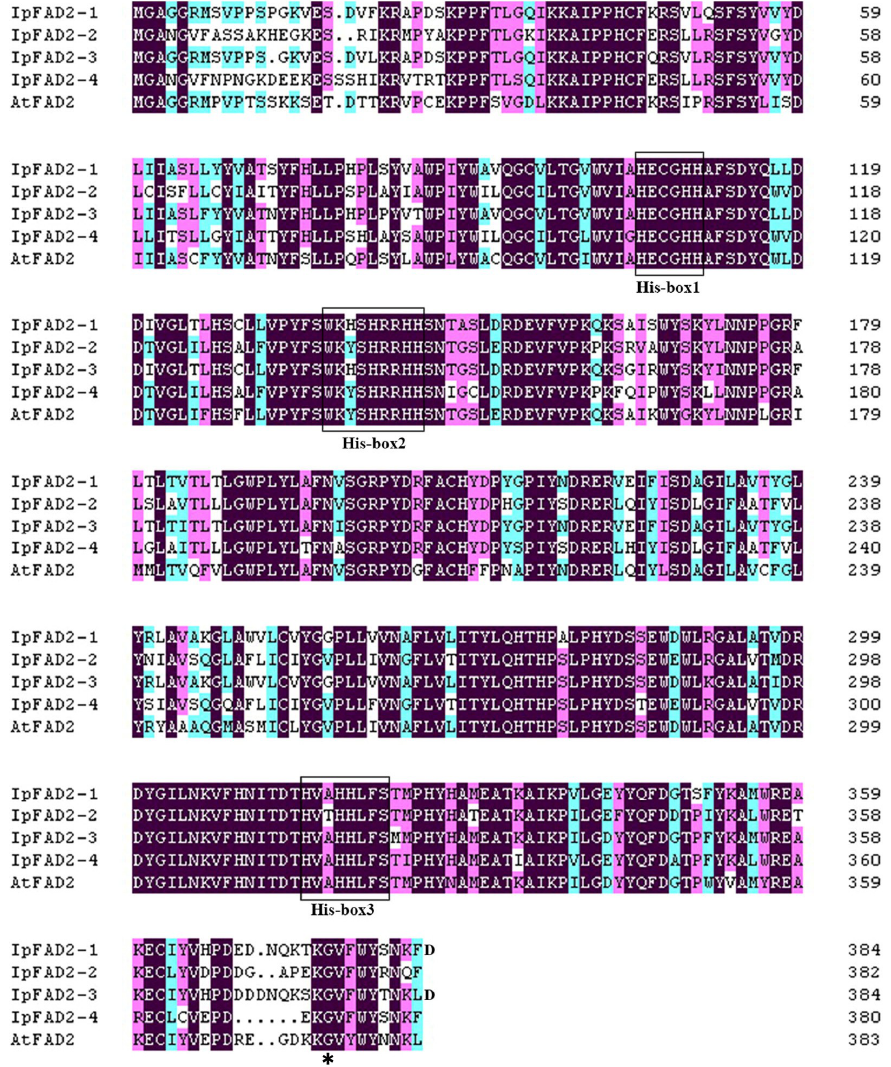
Figure 1. Alignments of predicted amino acid sequences encoded by FAD2 coding sequences from Idesia polycarpa and Arabidopsis thaliana. The three “histidine-rich motifs” are boxed. The GenBank accession numbers of IpFAD2-1 , IpFAD2-2 , IpFAD2-3, IpFAD2-4, AtFAD2 are: MH394208, MH394209, MH394210, MK105894, and NP_187819.1 accordingly. The shading colors represent the identity level of amino acids. Black, magenta, and cyan indicate 100%, 80%, and 60% identity, respectively. The asterisk indicates the conserved glycine.